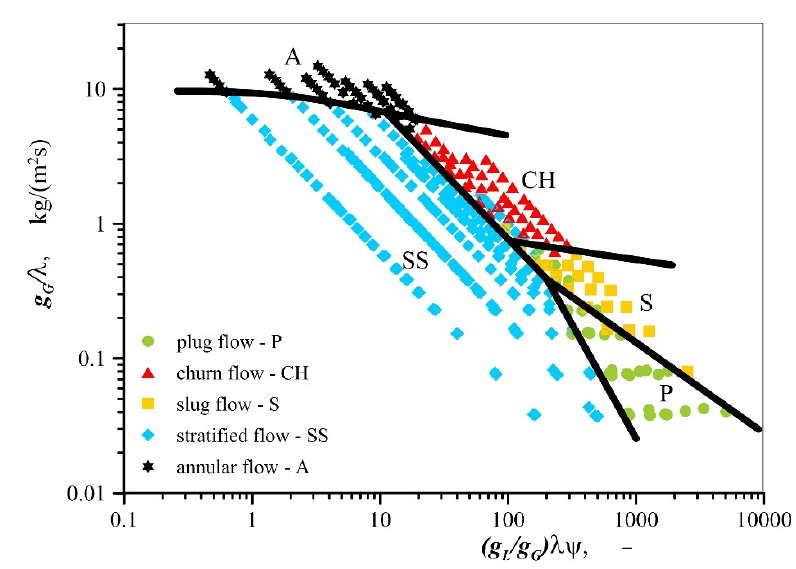
Figure 8. Gas − liquid flow map for horizontal flow through open − cell metal foams.